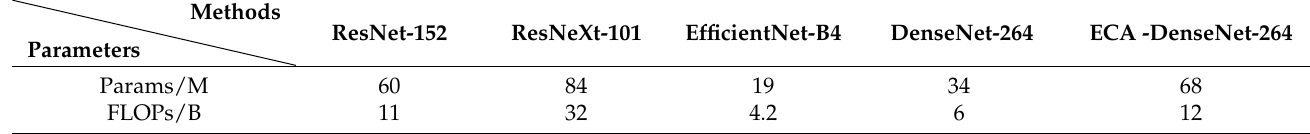
Table 3. Params and FLOPs of CNN